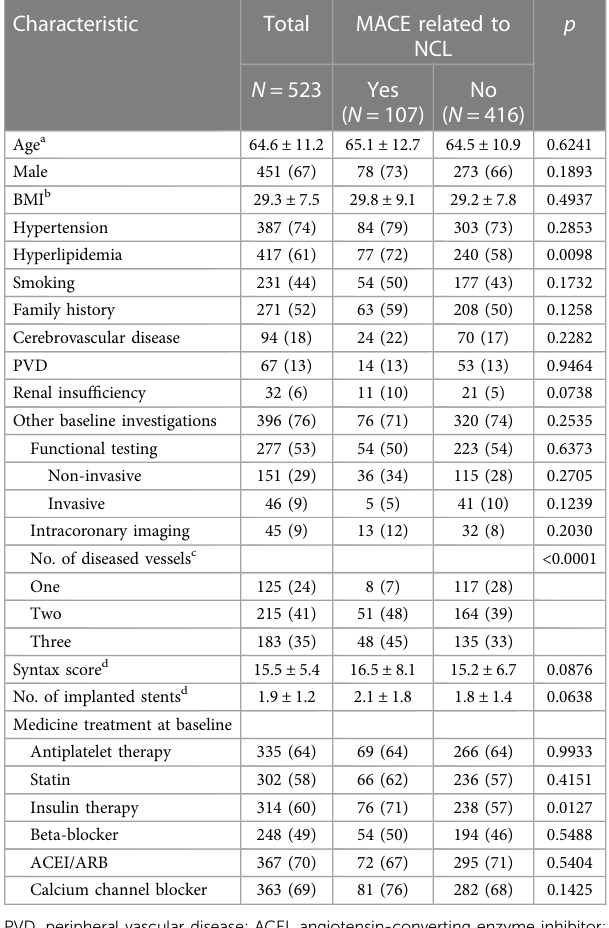
TABLE 1 Clinical and procedural characteristics of patients.